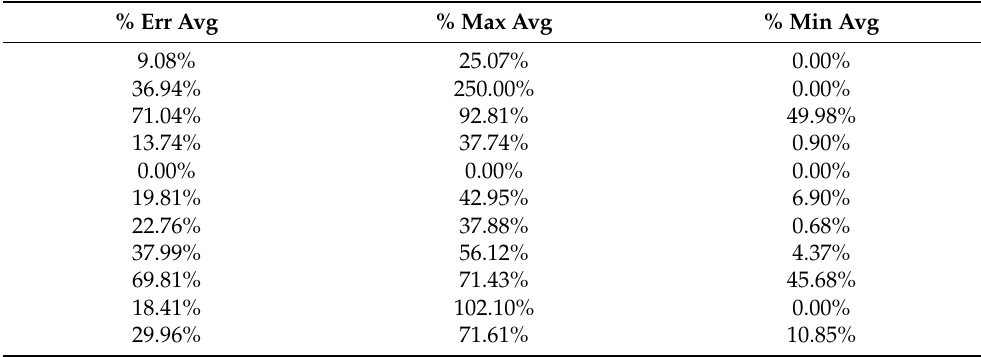
Table A225. Set 3, trials 41–50 data (single 0.5 PR value).